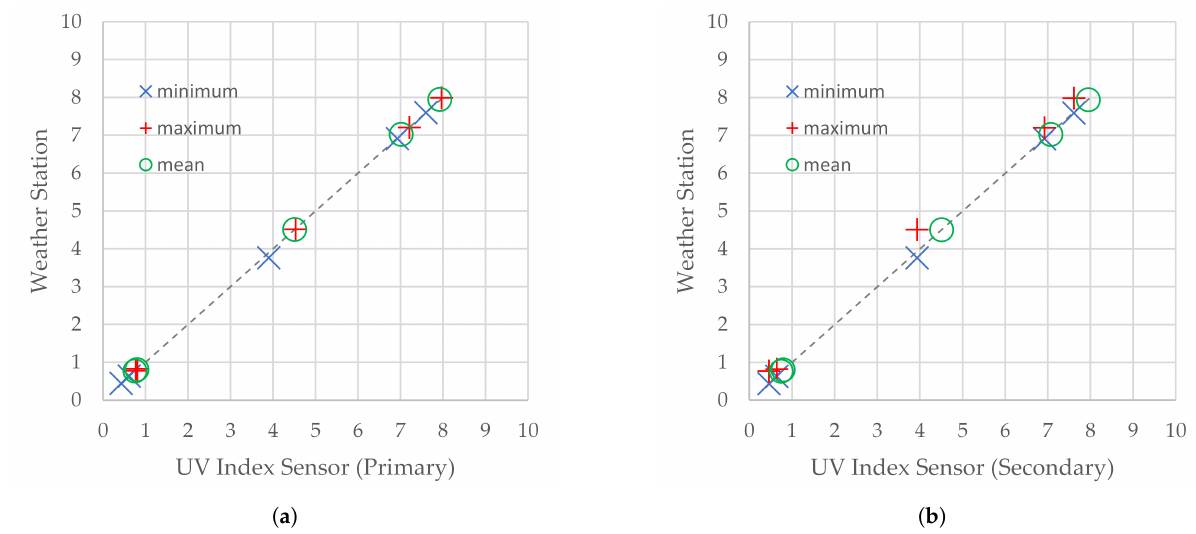
Figure 7. Scatter plots for statistics of UV index measured by the SBS-WS-400 reference weather station and ( a ) the primary UV index sensor of the flying weather station and ( b ) the secondary